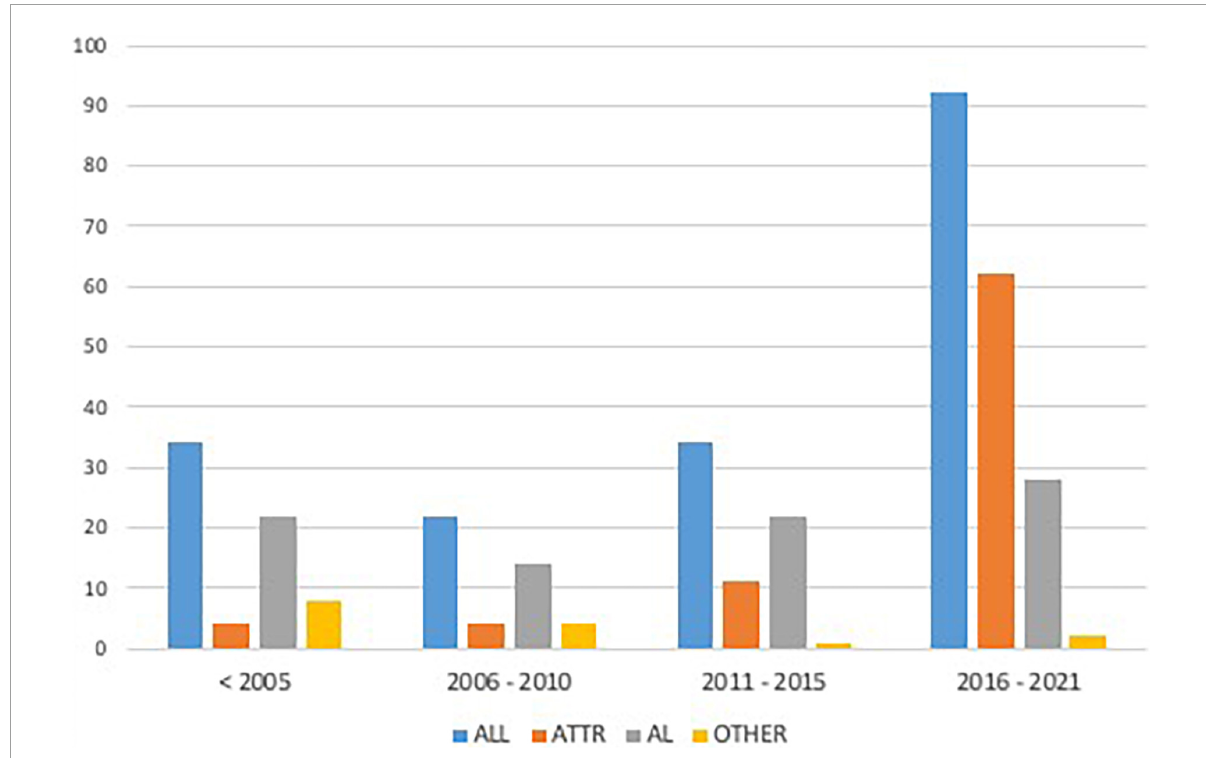
FIGURE1 Enrolment rate of the study population according to different periods. AL, Light Chain Amyloidosis; ATTR, Transthyretin